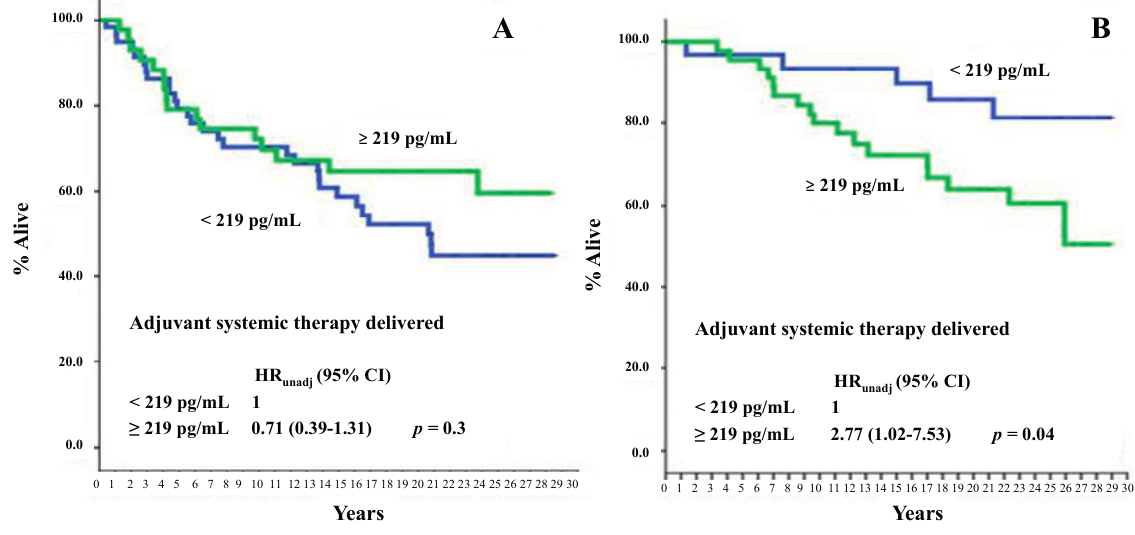
Figure 3. BCa-specific mortality of study patients as a function of serum PN values according to adjuvant systemic treatment ( A , B ). The median value, corresponding to 219 pg/mL, was used as an arbitrary cutoff. HR : hazard ratio; 95% CI : 95% confidence